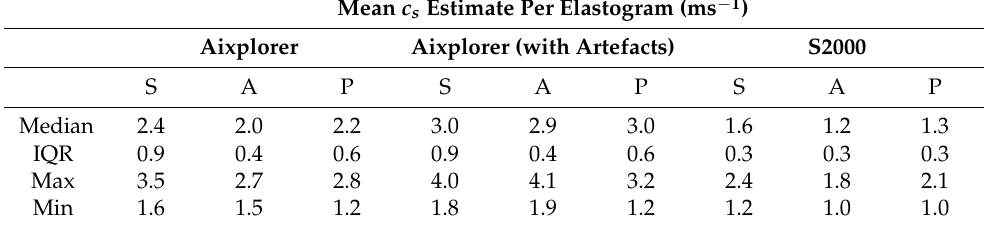
Figure 4. Showing: ( a ) Shear-wave speed ( c s ) estimates for skin, adipose and parenchyma using Aixplorer (excluding artefacts) and S2000, and; ( b ) c s estimates for skin, adipose and parenchyma measured using Aixplorer including and excluding artefacts. Median is illustrated by the central horizontal bar; the horizontal box edges show the IQR and the whiskers (dashed lines) show the range. Range is defined by adjacent values, which are the 25th or 75th quartile plus or minus the IQR multiplied by 1.5. Opposing triangles illustrate the 95% confidence interval on the median c s and ‘+’ indicates an outlier (any value outside the adjacent values). *** indicates where machine c s estimates were significantly different with p -value < 0.001. Table 2. Median, Interquartile range (IQR) max and mean shear-wave speed ( c s ) estimates from the Aixplorer and the S2000 across all elastograms measured in skin adipose and parenchyma. S = skin, A = adipose and P =